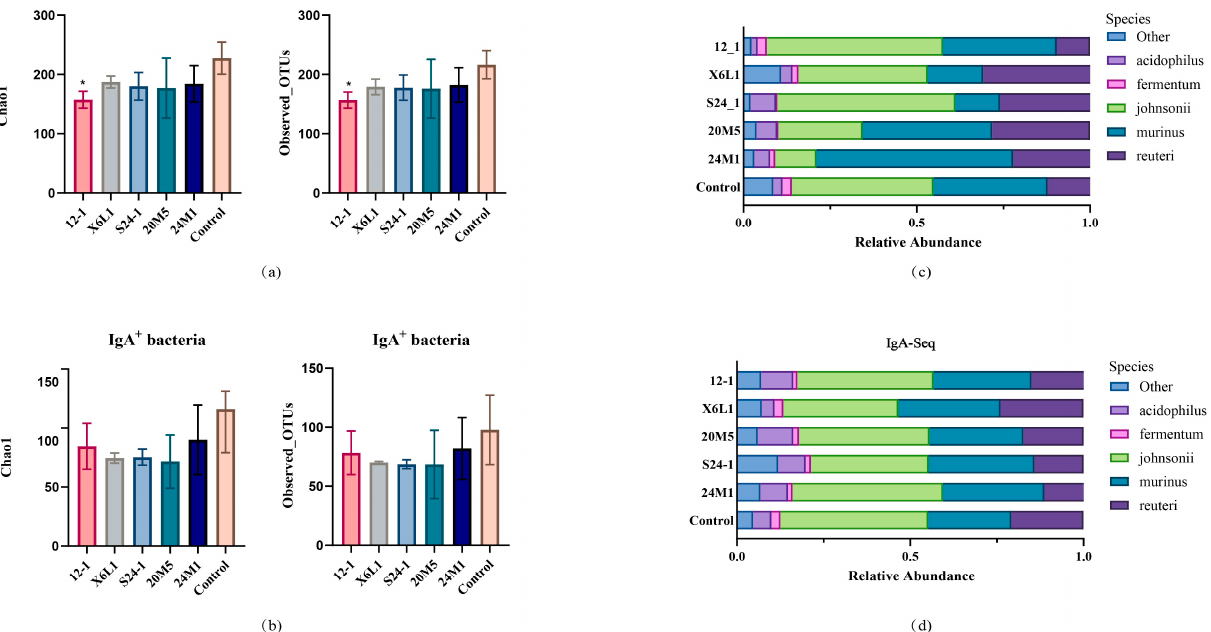
Figure 5. Effect of L. fermentum on gut microbiota in mice at α diversity and species level. ( a ) Mouse colon contents bacterial α -diversity calculated by Chao1 and observed OTUs; “*” indicates p < 0.05. (Compared with control group). ( b ) IgA-coated bacterial α− diversity calculated by Chao1 and observed OTUs; ( c ) 16S rDNA sequencing of mouse colon contents, relative abundance of Lactobacillus species level; ( d ) IgA − coated bacteria 16S rDNA sequencing of mouse colon contents, relative abundance of Lactobacillus species level.